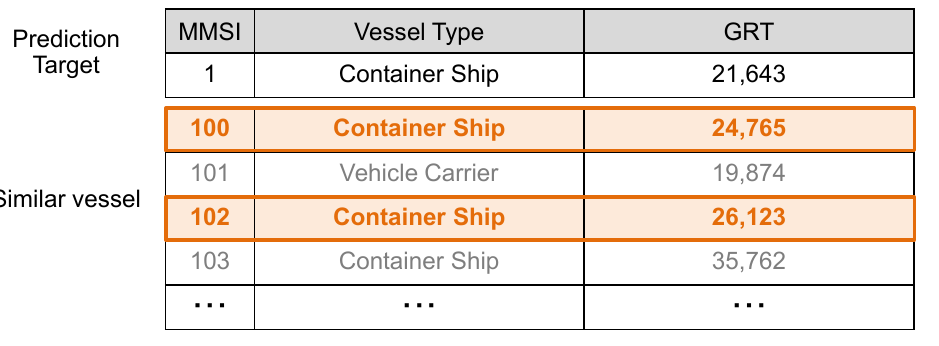
Figure 5. Example of similar vessels.